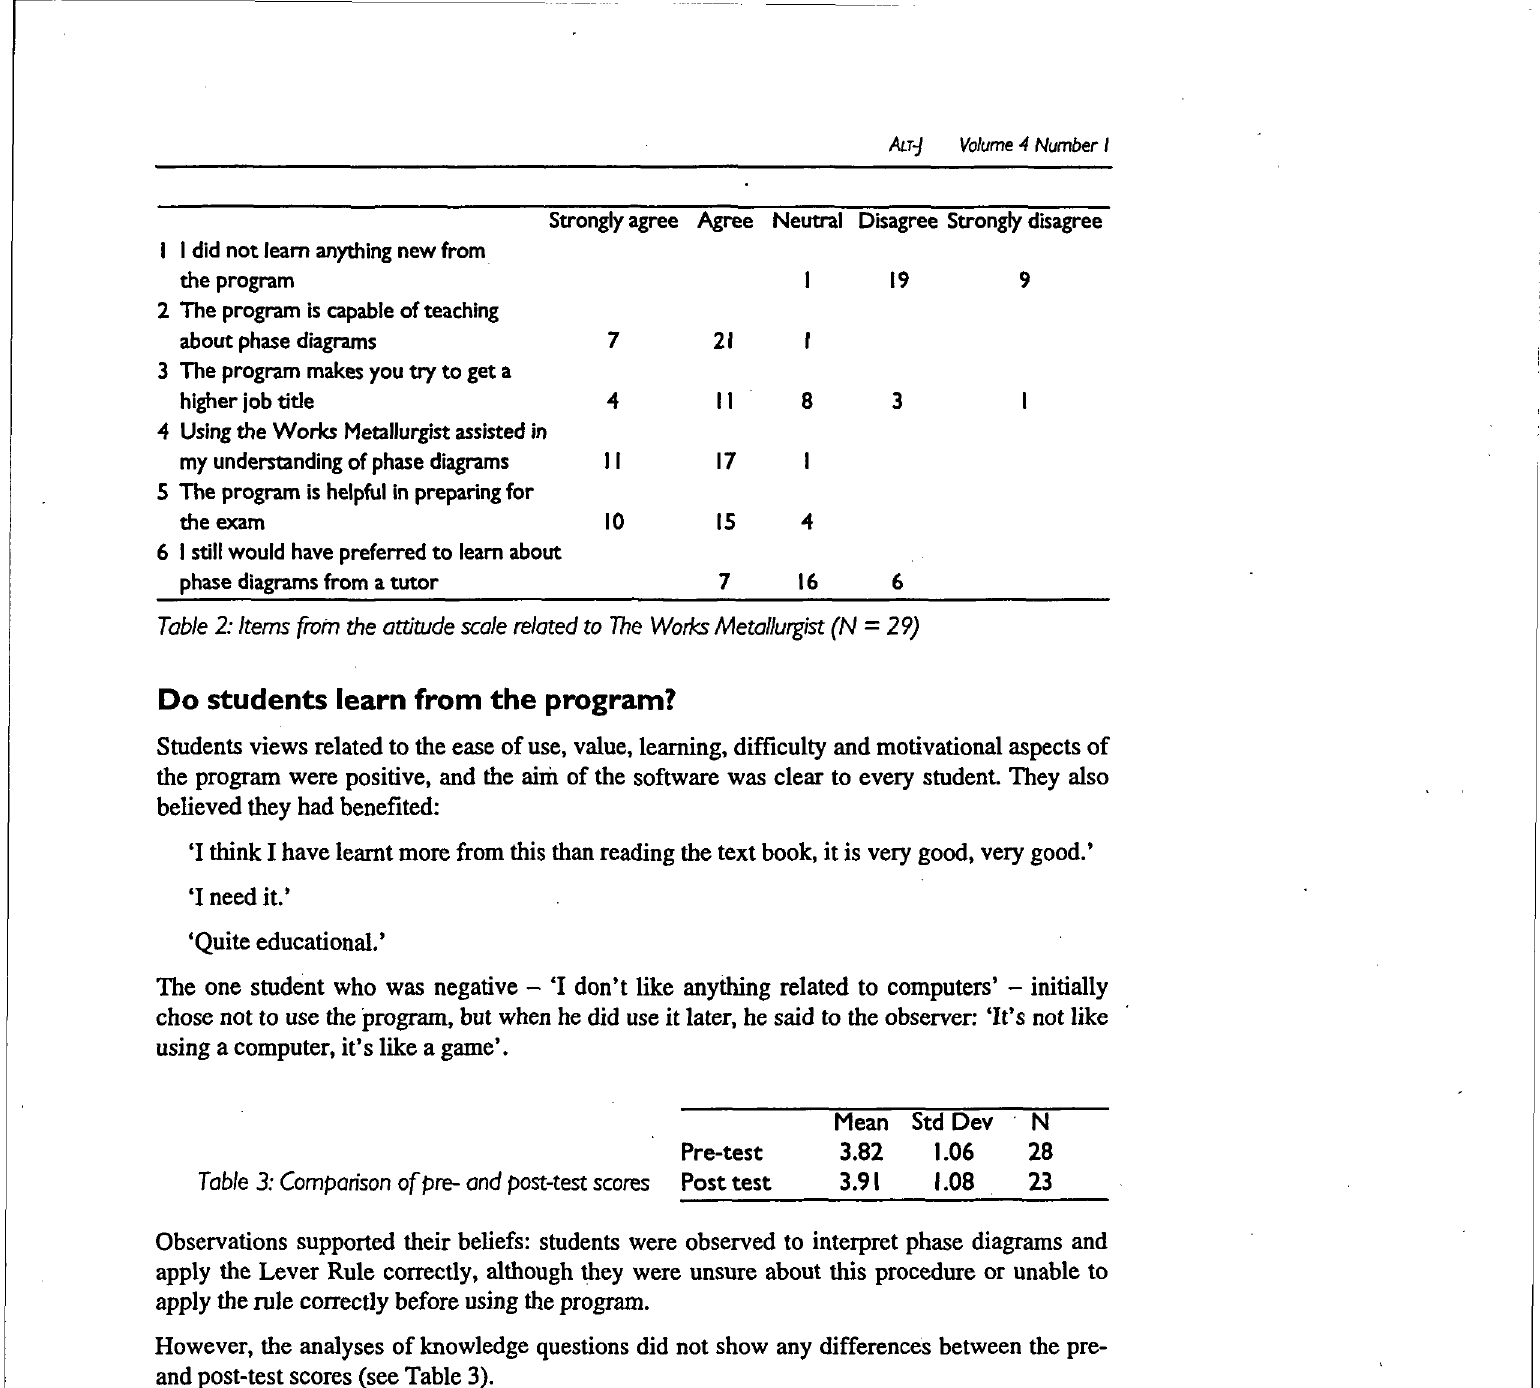
23 Table 3: Comparison ofpre- and post-test